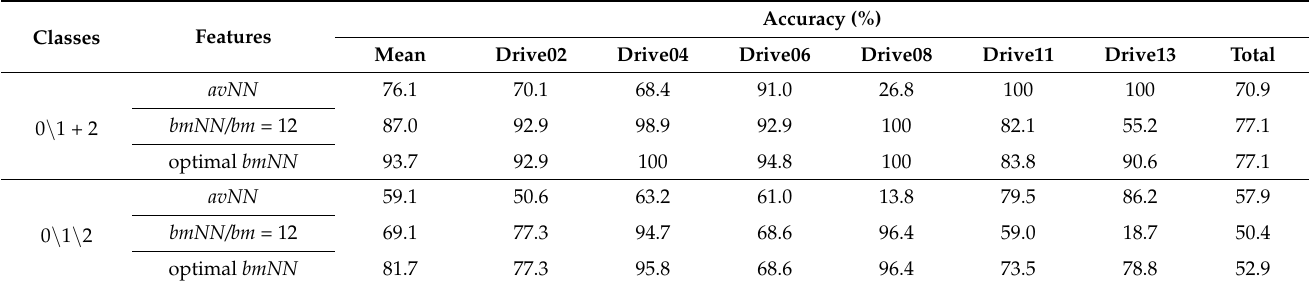
Table 2. Classification results of Drive02 \ 04 \ 06 \ 08 \ 11 \ 13 as two or three categories.